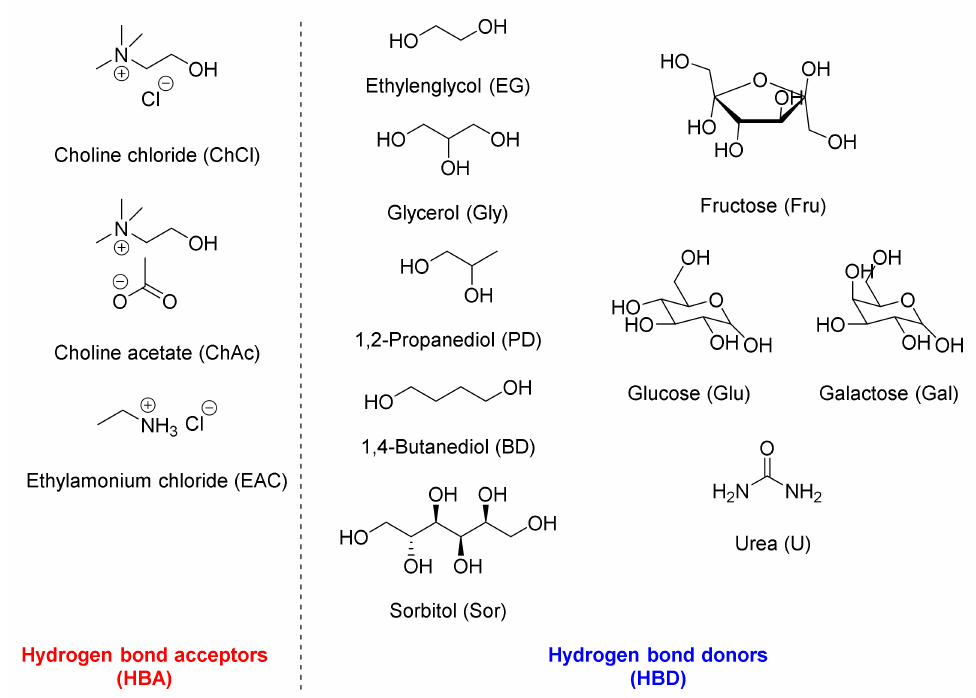
Figure 2. Structure of the components of the (NA)DESs described in the present